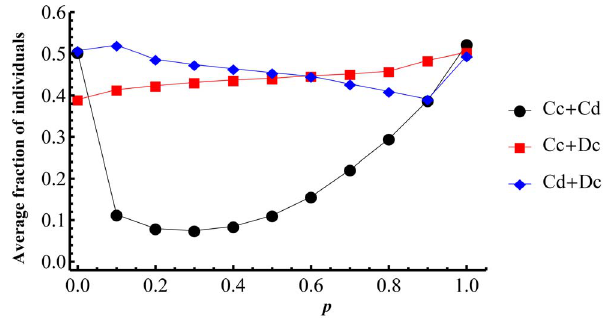
Figure 4. The average fractions of Cc z Cd as PD C, Cc z Dc as SD c, and Cd z Dc in dependence on p . For each p , the simulations run on 51 | 51 square lattice with ( u , v ) in discrete u { v parameter plane. The initial average fractions of the four types are all 0 : 25 . doi:10.1371/journal.pone.0081855.g004 indicate the population structure with pure SD game. The right endpoints of the curves correspond to the case p ~ 1 , which indicate the population structure with pure PD game. Comparing with these reference endpoints the average fractions of Dc and Dd form two convex curves, and the average fractions of Cc and Cd form two concave curves. It is quite obvious that from the global perspective, mixing SD and PD games will stimulate Dc and Dd , and inhibit Cc and Cd individuals.